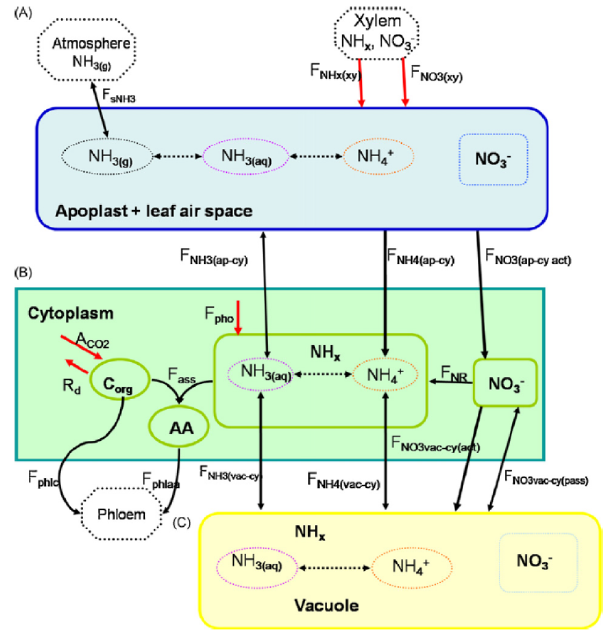
Fig. 5. Components and flow diagram of the STAMP (stomatal am- monia compensation point) model by Massad et al. (2010a). One- way arrows represent active transport, two-way arrows represent passive diffusion, dotted arrows represent equilibria and red arrows represent forcing